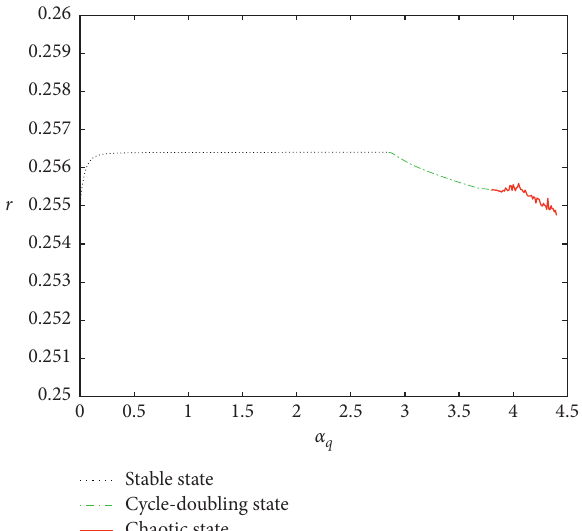
Figure 12: The average recycling ratio of recycler in different states of system (25).